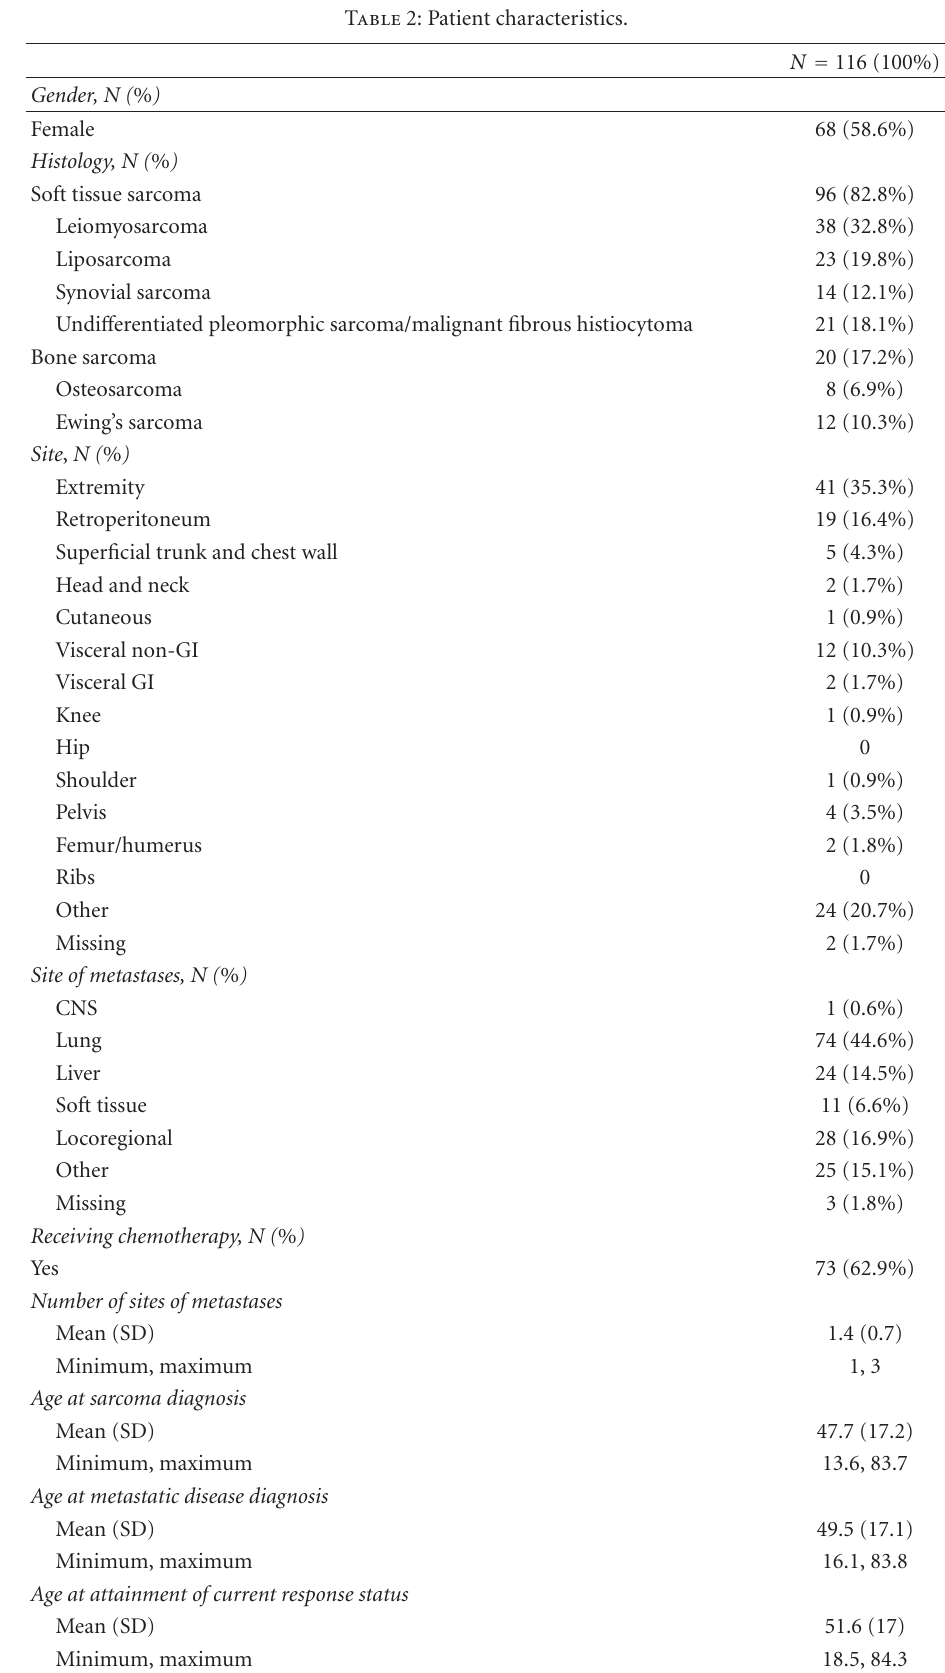
Table 2: Patient